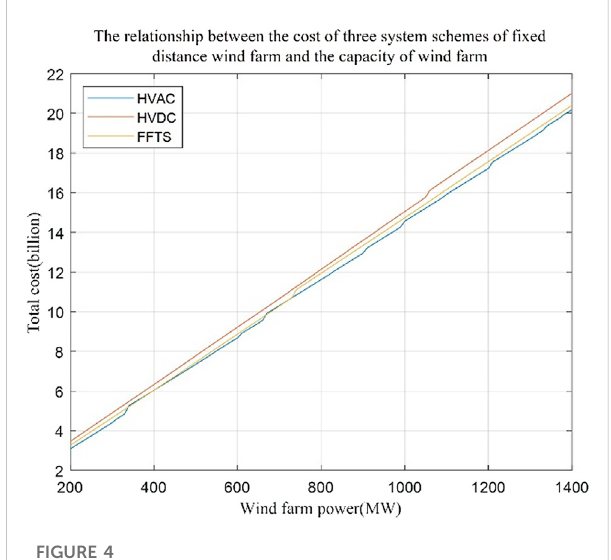
FIGURE 4 Comparison of cost transmission capacity curves of three schemes of 50 km wind farm.